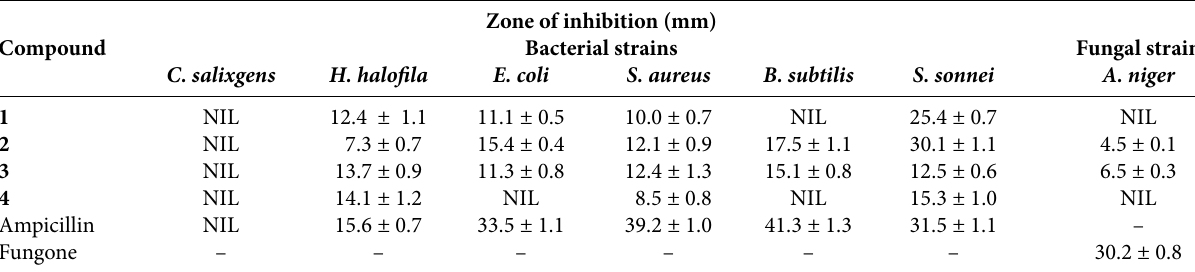
Zone of inhibition (mm)